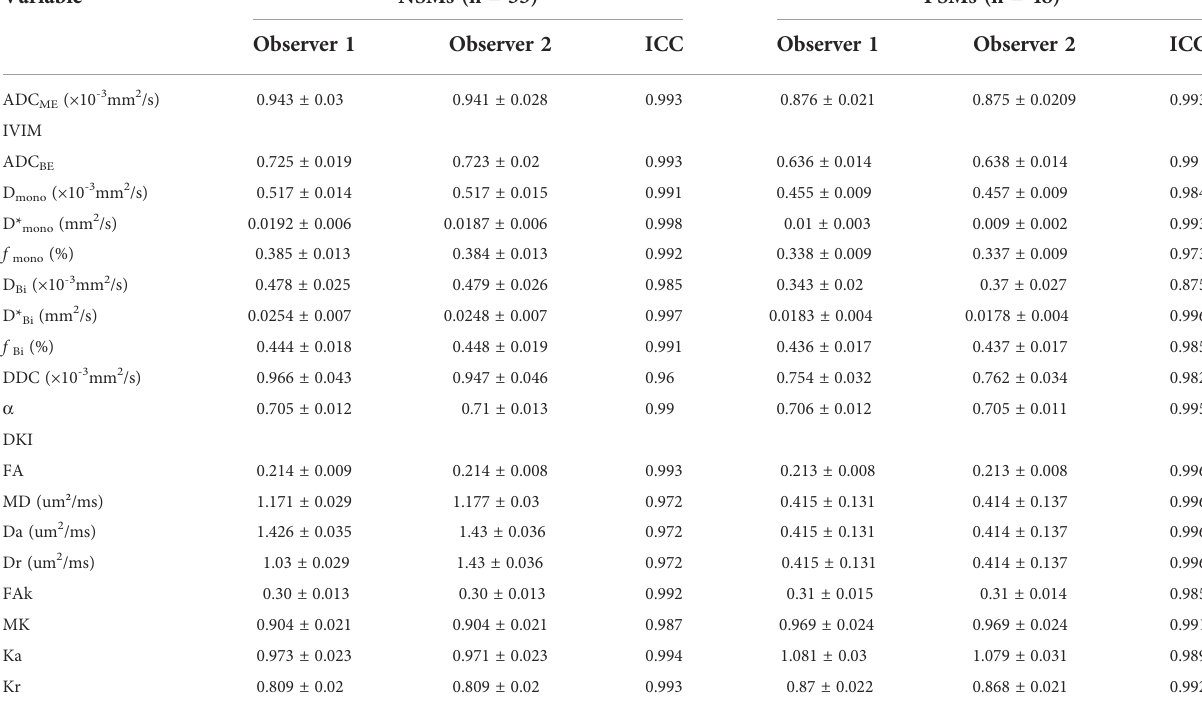
TABLE 5 Two-observer measurement consistency.